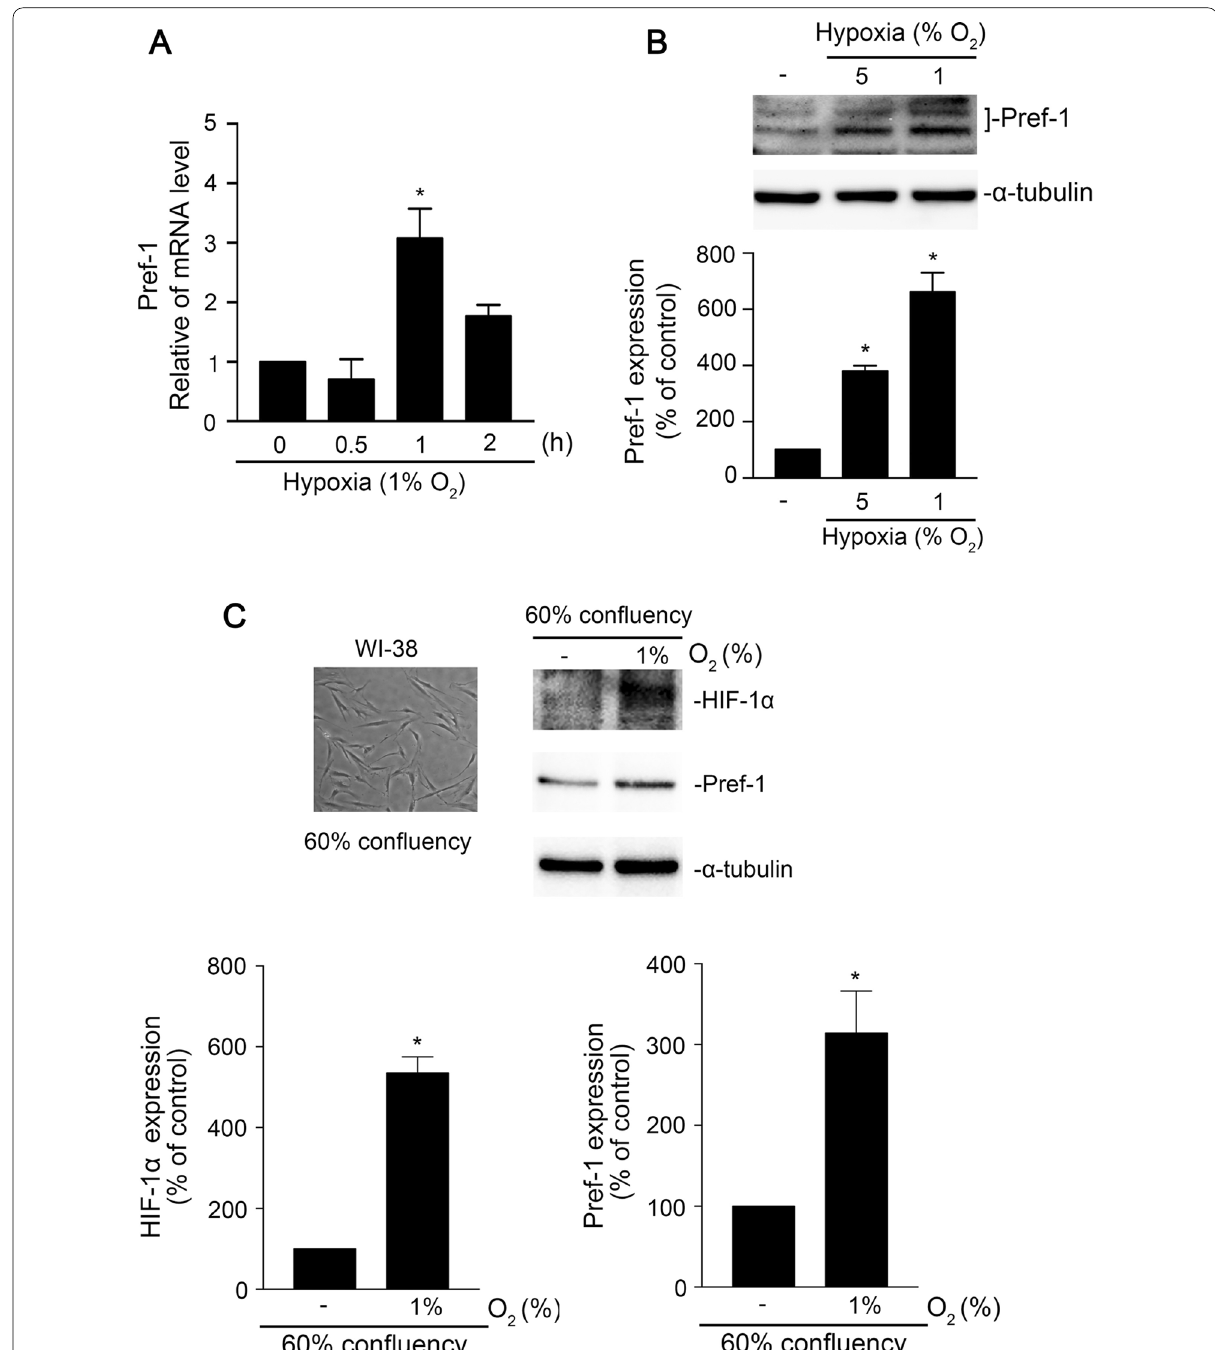
Fig. 2 Hypoxia‑induced Pref‑1 expression in WI‑38 cells. A 90% confluency WI‑38 cells were incubated with 1% O 2 for 0–2 h. The levels of Pref‑1 messenger RNA were detected by using qPCR. Data are presented as the mean S.E.M. of three experiments. B 90% confluency WI‑38 cells ± were incubated with different oxygen concentrations for 4 h, and then, Pref‑1 and α‑tubulin were determined through immunoblots. These are presented as the mean S.E.M. (n 3). * P < 0.05, compared with control (at O 2 21%). C 60% confluency WI‑38 cells were exposed with 1% O 2 for ± = 4 h. HIF‑1α, Pref‑1, and α‑tubulin were detected through immunoblots. These are presented as the mean S.E.M. (n 4). * P < 0.05, compared with ± = control (at O 2